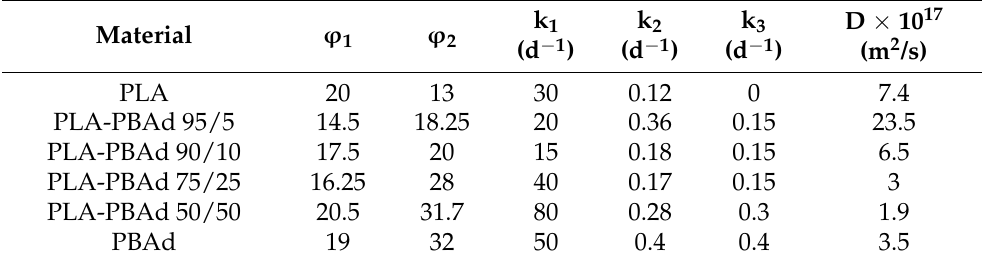
Table 6. Parameters derived by fitting Equation (9) to the experimental drug release data.